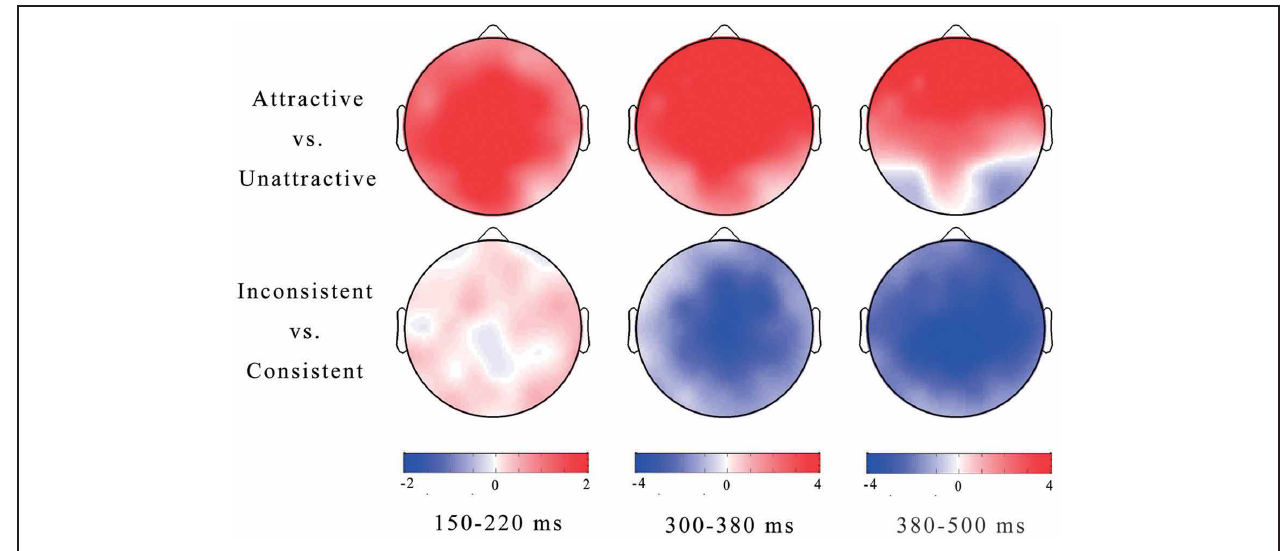
FIGURE 3 | Topographies of ERP effects in three time